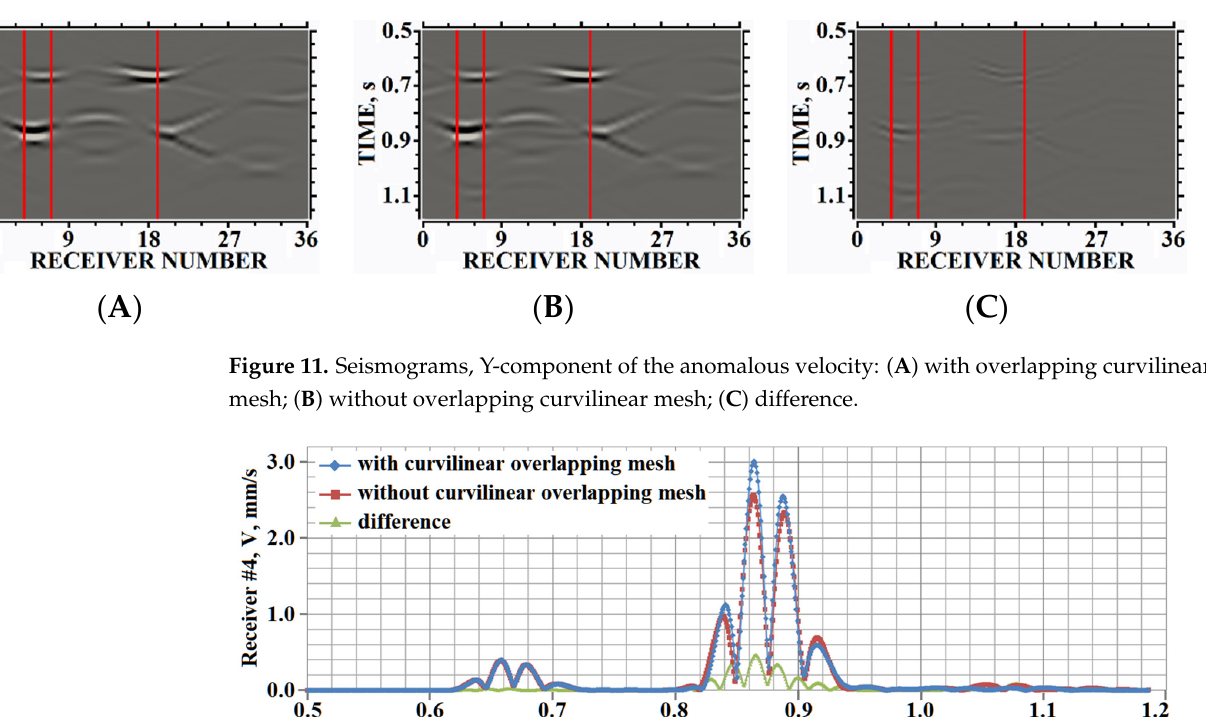
Figure 12. Receiver #4, dependencies of velocity modulus on time.